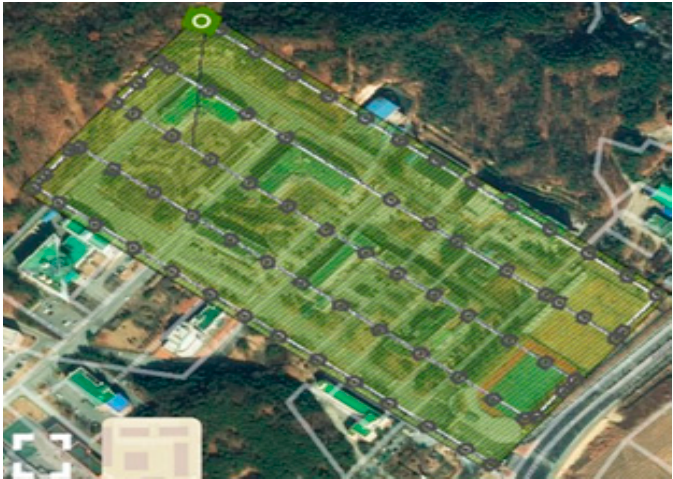
Figure 4. Flight course over the study area. The gray circles indicate the location of the image acquisition.